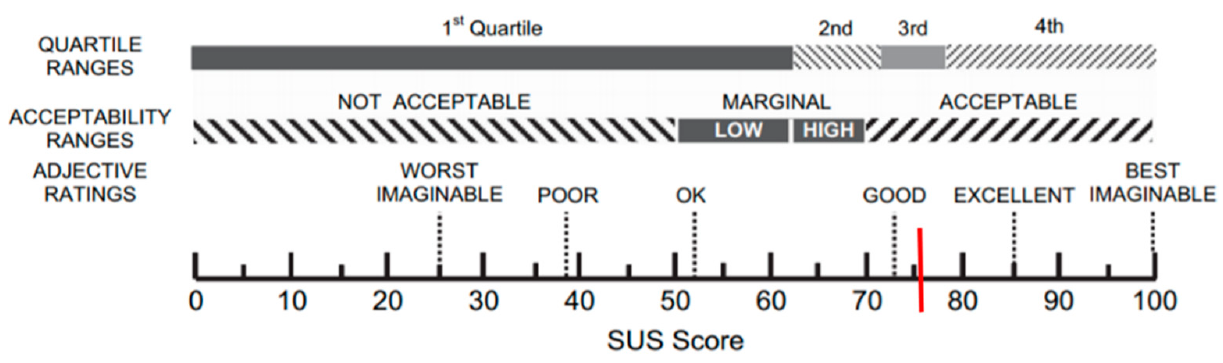
Figure 1. A graphic representation of the SUS score. The figure is modified from the original version (Bangor et al. 2008).